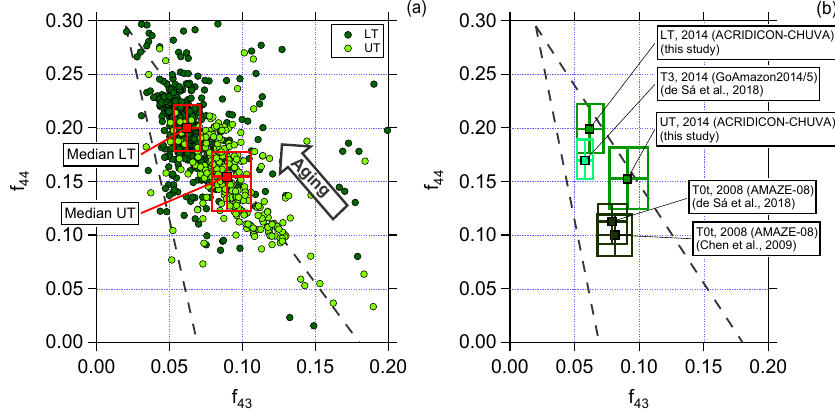
Figure 4. Scatter (triangle) plot of f 44 against f 43 for (a) the lower troposphere (dark green, LT) and upper troposphere (light green, UT) for 2min averaged data and (b) a comparison between different field campaigns performed in the Amazon region. Dashed lines indicate a triangular area according to the criteria introduced by Ng et al. (2010). Squared colored markers and boxes show median values and interquartile ranges for LT and UT,